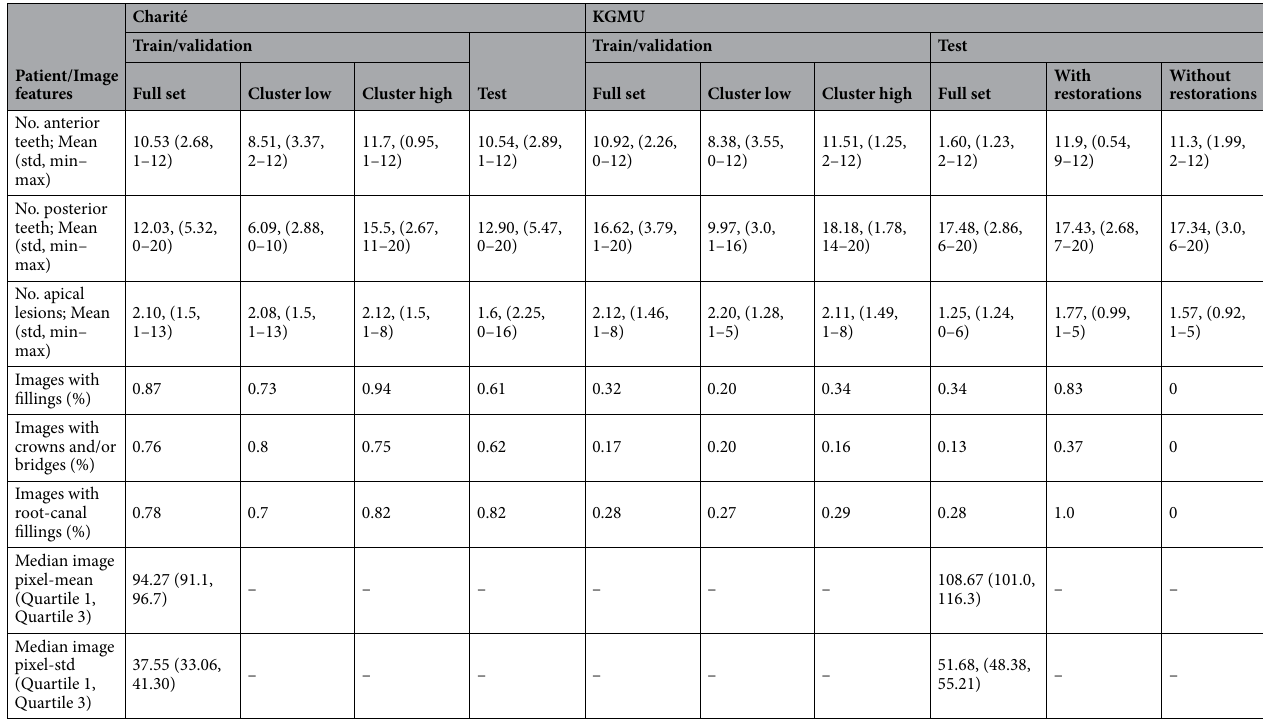
Table 1. Characteristics of the different datasets. For the Charité and KGMU training sets, the clusters featuring a high/low number of teeth, as well as the full set where both clusters were combined. In the case of the KGMU test set, two additional subsamples were considered, one with root-canal fillings and restorations being present and the other without